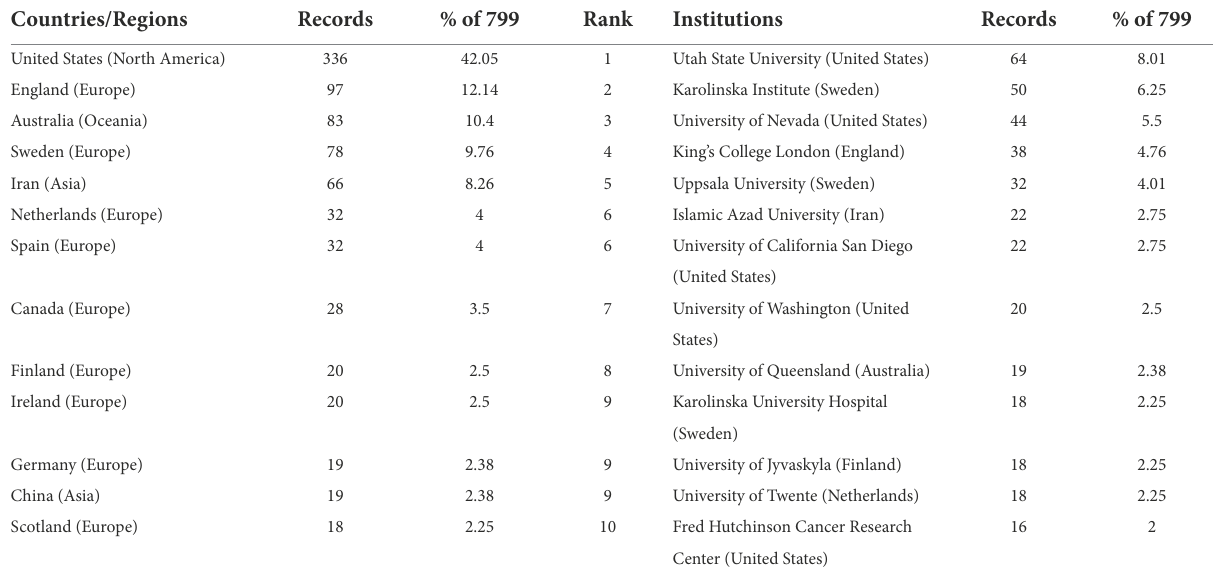
TABLE 2 The top 10 most productive countries/institutions in ACT